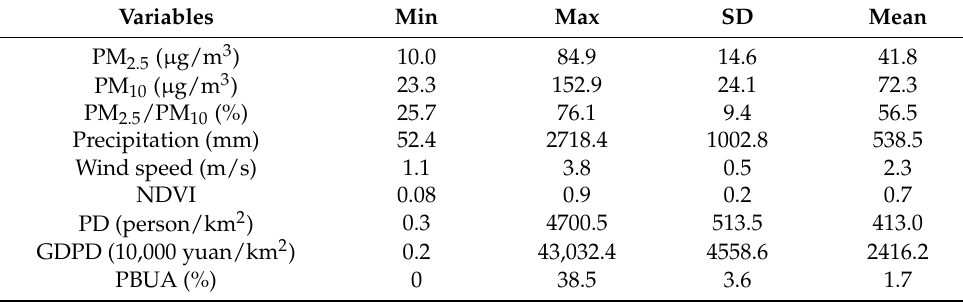
Table 2. Characteristics of PM and its influencing variables in